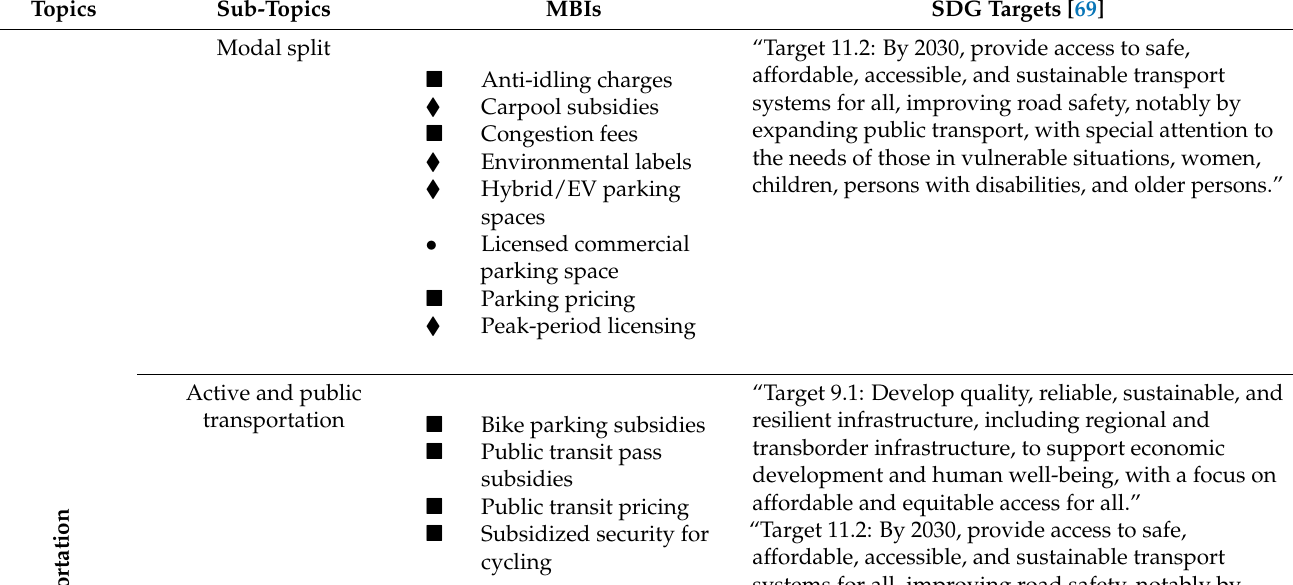
Table 3. Categorization of MBIs for Transportation and Related SDG